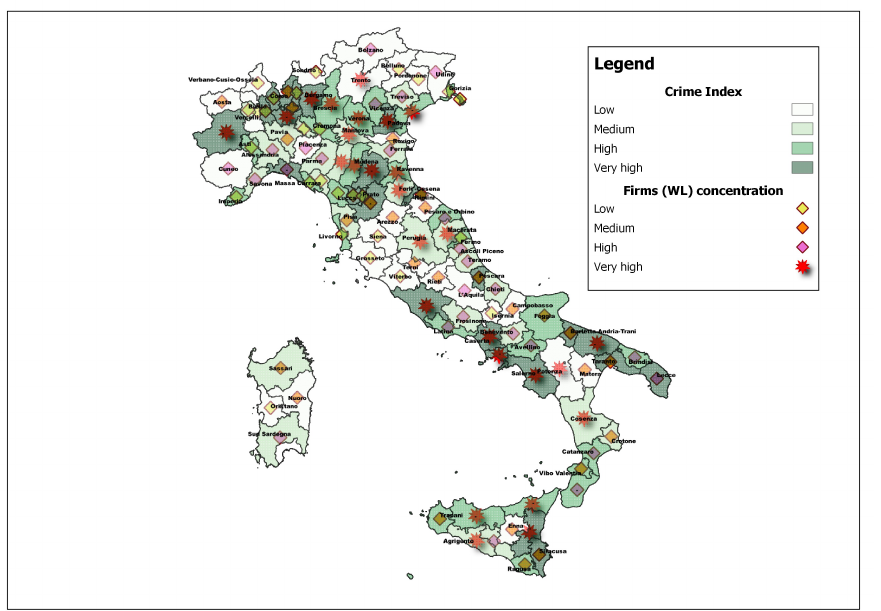
Figure 5. Organised crime variable and number of firms (WL). Source: Authors processing of AIDA Bureau Van Dijk and Prefectures